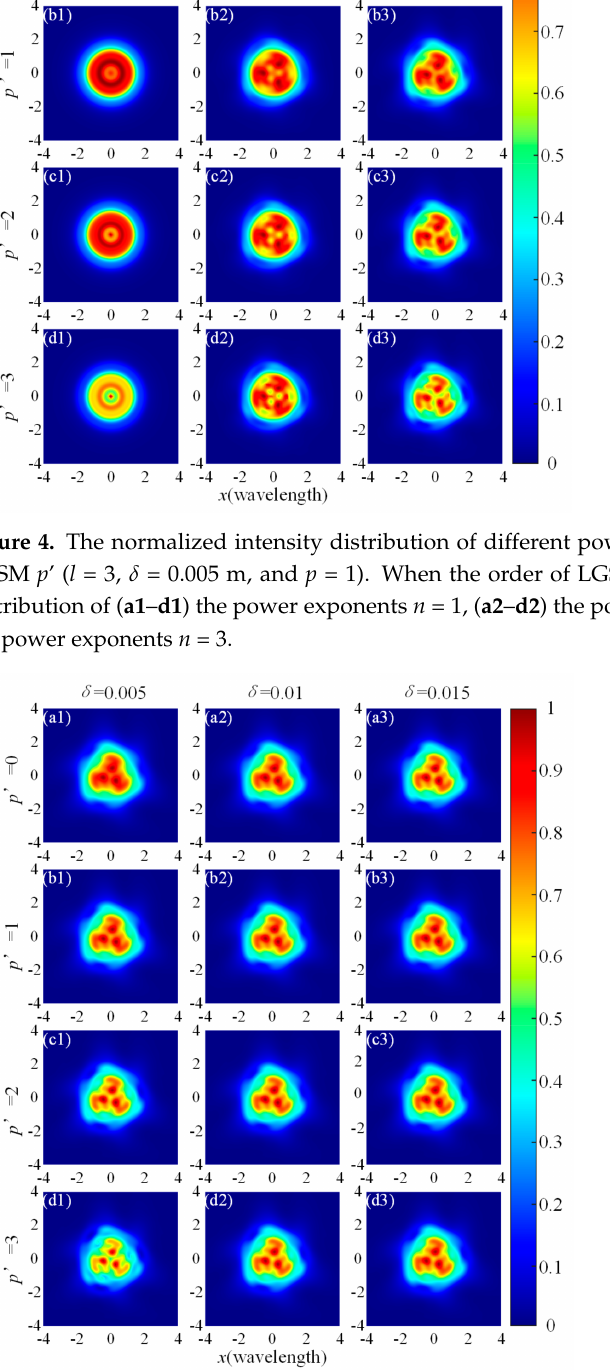
Figure 5. The normalized intensity distribution of different the spatial correlation lengths δ and the order of LGSM p ’ ( l = 3, n = 4, and p = 1). When the order of LGSM p ’ is 0 to 3, the total intensity distribution of ( a1 – d1 ) the spatial correlation lengths δ = 0.005 m, ( a2 – d2 ) the spatial correlation lengths δ = 0.01 m, and ( a3 – d3 ) the spatial correlation lengths δ = 0.015